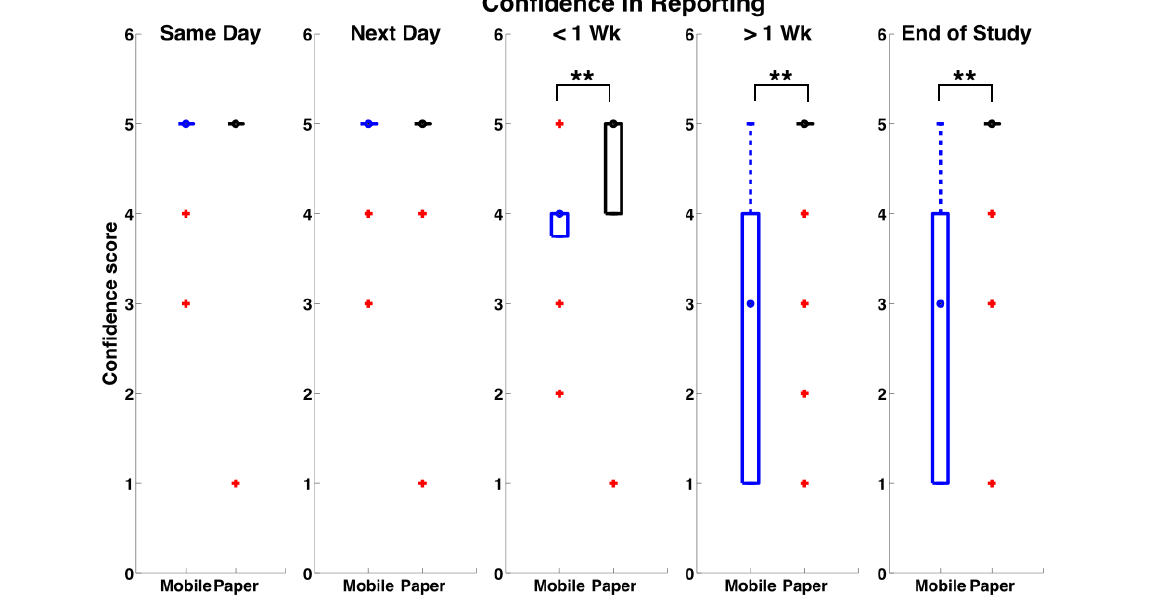
Figure 5. Boxplots showing that confidence in self-report significantly decreased for participants in Mobile condition (Blue) compared to ones in ePaper condition (Black) when self-reporting occurred further away in time with respect to activity occurrence: < 1 week ( P < .001), > 1 week ( P < .001) and End of study ( P < .001). Circles represent medians, boxes represent interquartile intervals and + (Red) represent